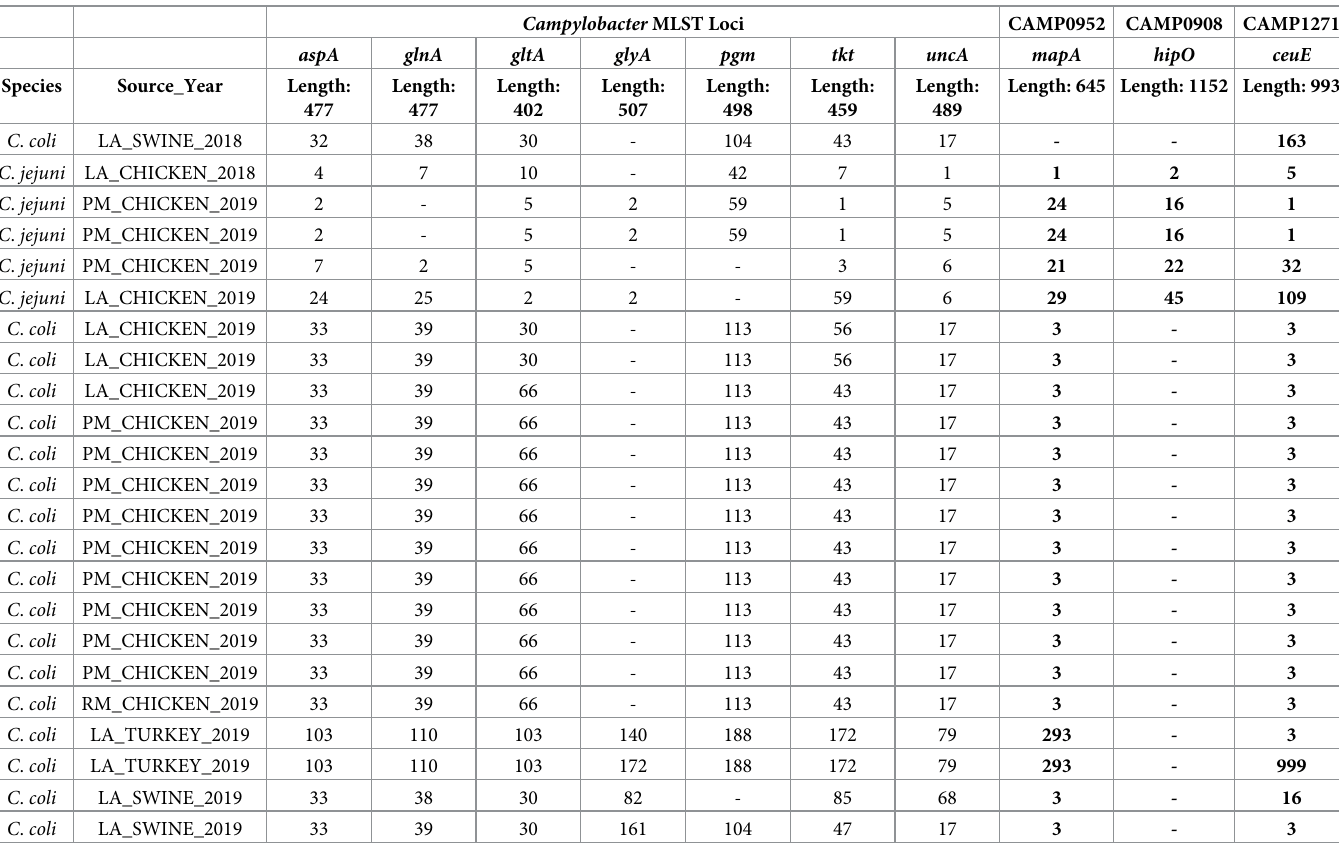
Table 1. Novel ST MLST loci and allele matches for C . Jejuni and C . coli species specific genetic